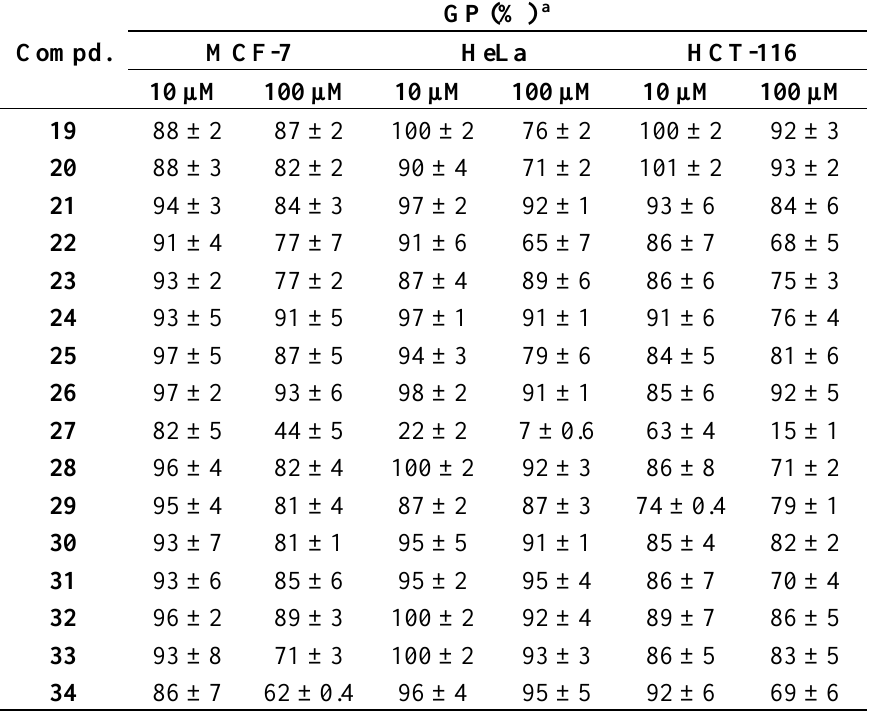
Table 4. Cytotoxicity of compounds 19 ‒ 47 toward human cancer cell lines.